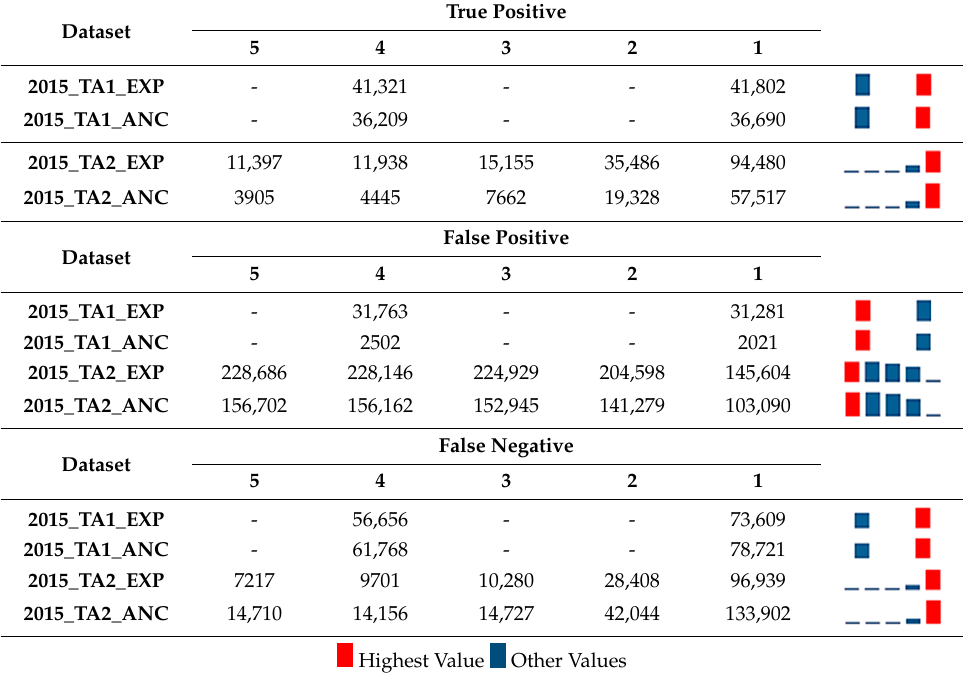
Table 4. The size (in m 2 ) of true positive, false positive and false negative obtained by comparing classification results with the level of agreement. 2015_TA1_EXP indicates the year of the image, TA1 gives the location of the first test area (TA). EXP indicates that we only used explicit/observable indicators, while ANC means that we include an ancillary (not observable in images) indicator.